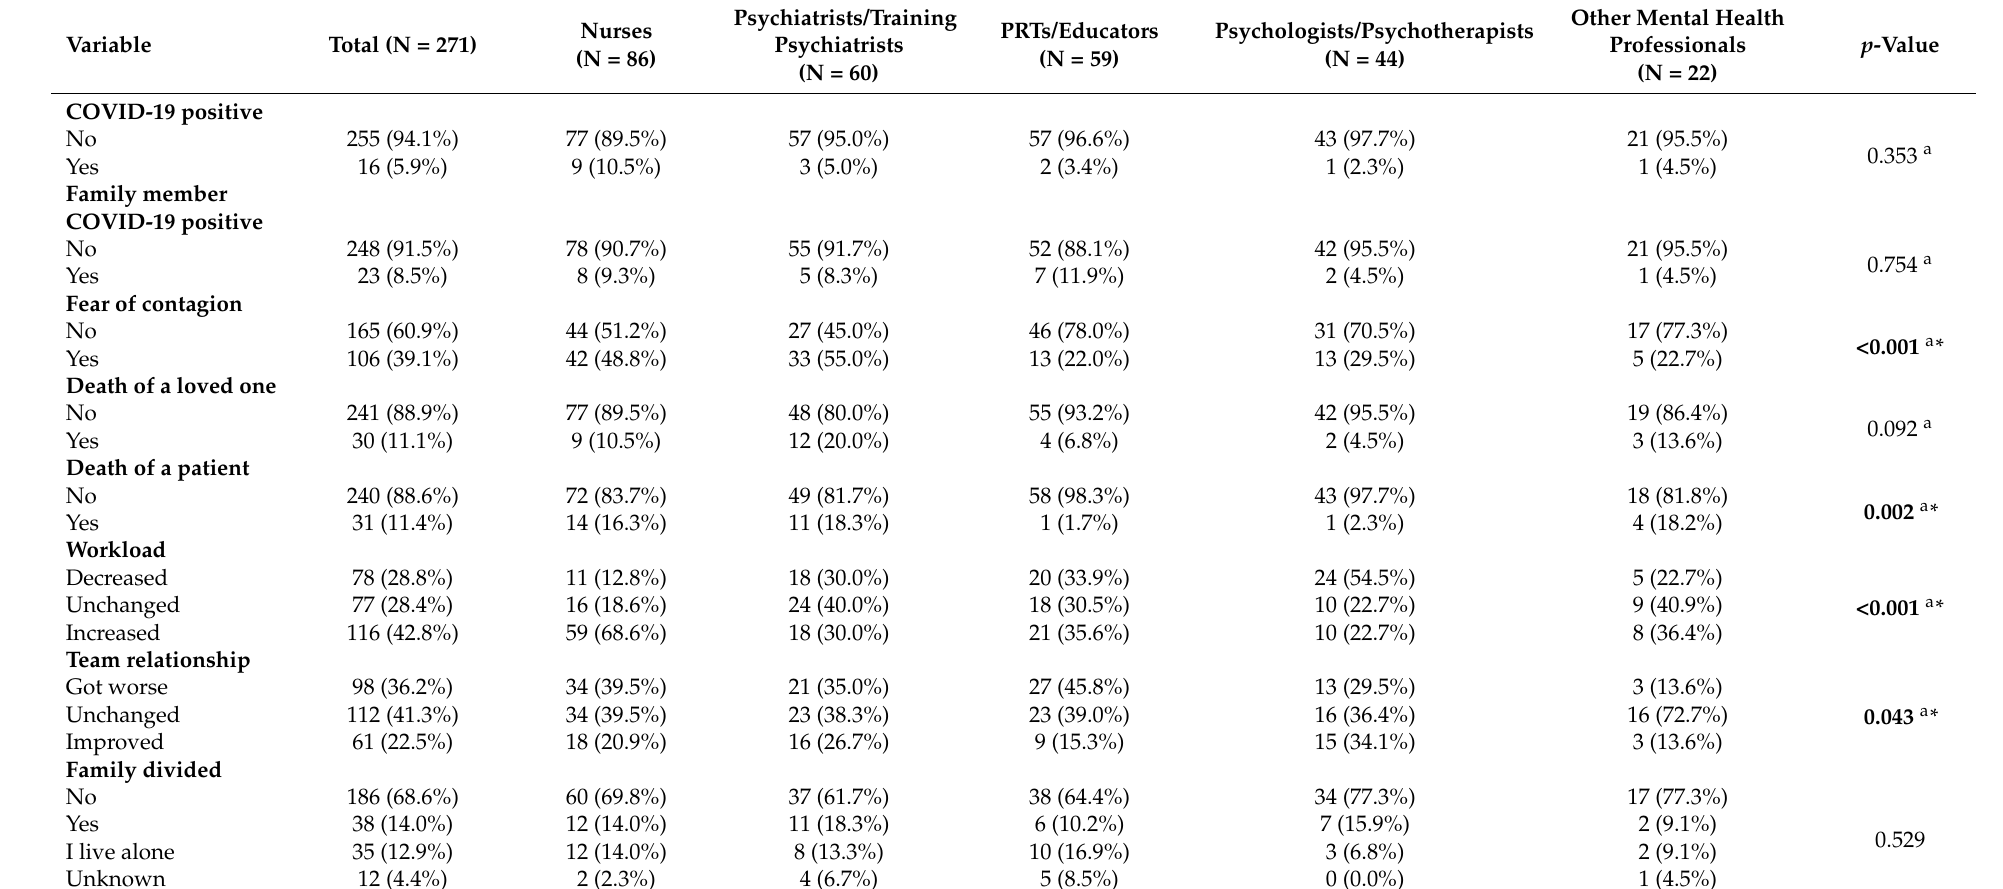
Table 2. Descriptive statistics of events that happened during the analyzed COVID-19